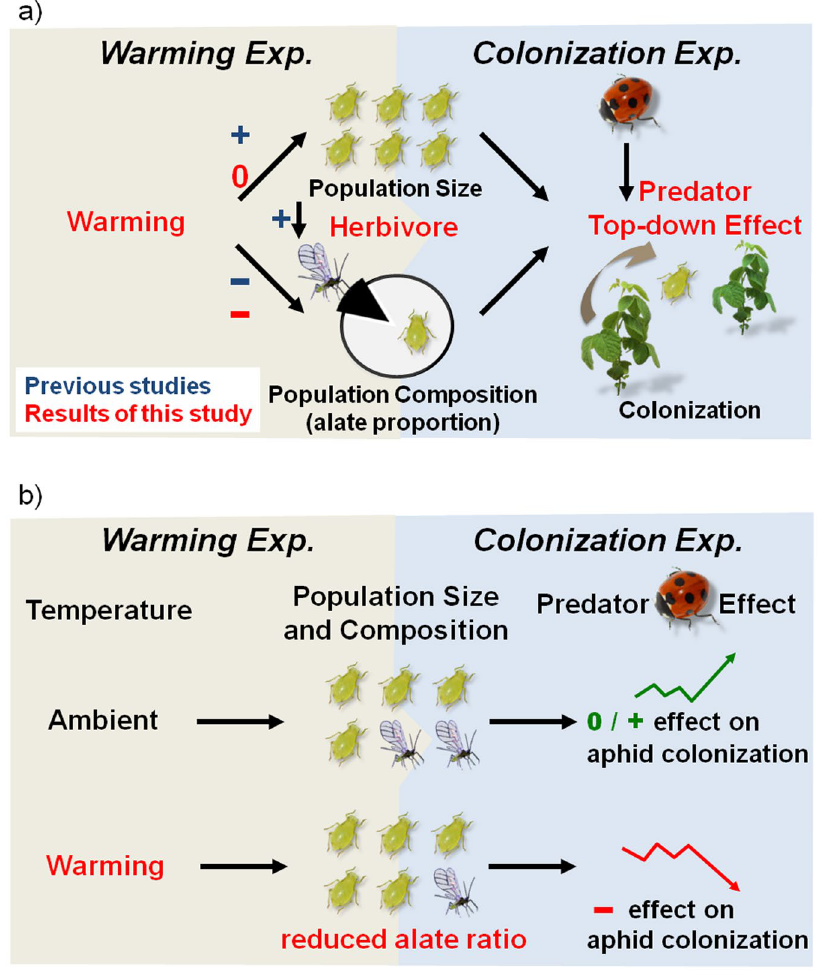
Figure 1. ( a ) The concept map of this study, including two experiments: warming experiment examining warming impact on herbivore population size and composition, and colonization experiment examining the subsequent effect on herbivore colonization with/without predators. While previous studies suggested that higher aphid population size could lead to higher alate proportion (crowding effect), this study did not explore this relationship because the warming experiment showed no warming impact on aphid population size. Note that + , − , and 0 indicate positive, negative, and no effects, respectively. ( b ) The simplified results of this study: warming affected the herbivore population composition (reduced alate proportion) without changing the population size, and this warming-induced effect could interact with predator (lady beetle) effect in influencing herbivore colonization. Note that + , − , and 0 indicate the positive, negative, and no effects, respectively, of predator presence on aphid